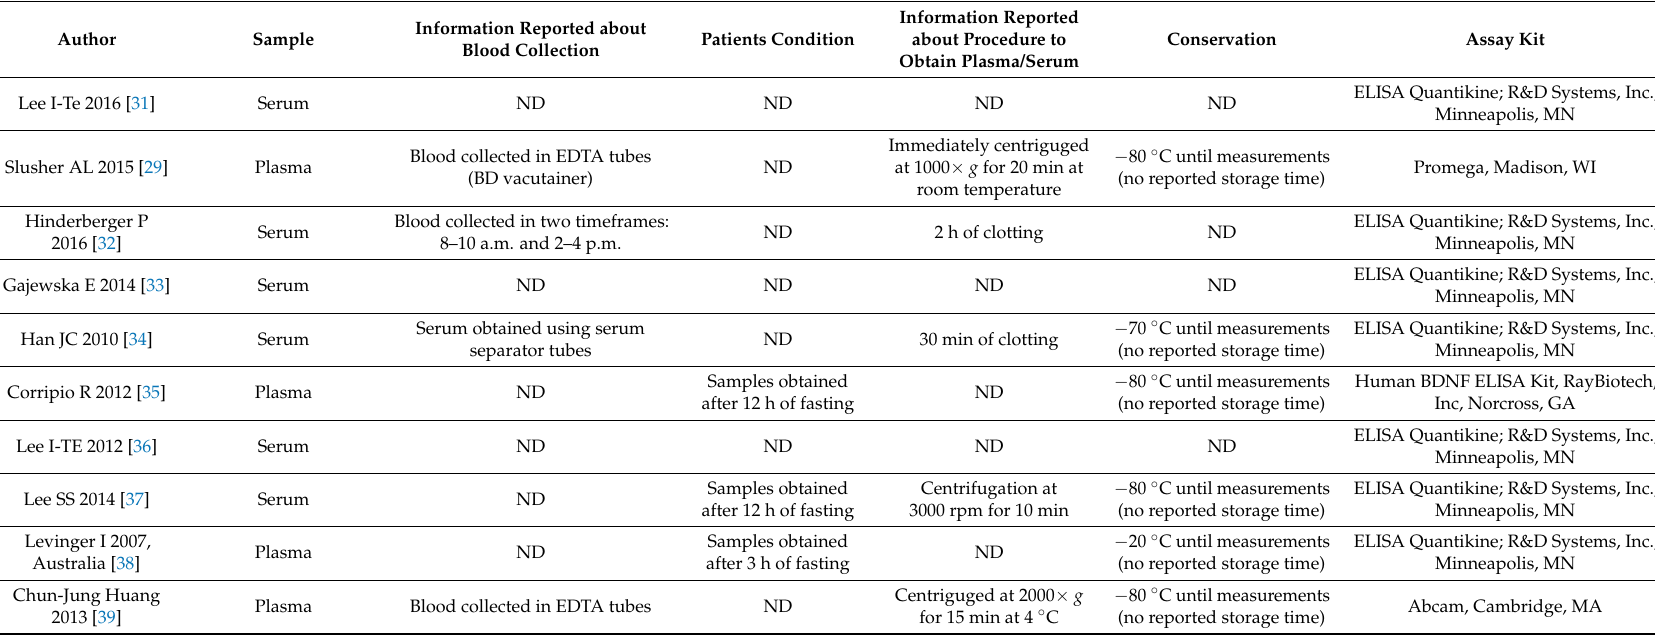
Table 4. Characteristics regarding procedures of sampling, patients condition, handling, storage, and measurements of